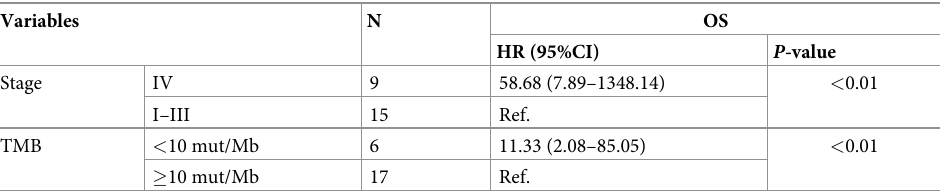
Table 5. Multivariate association with overall